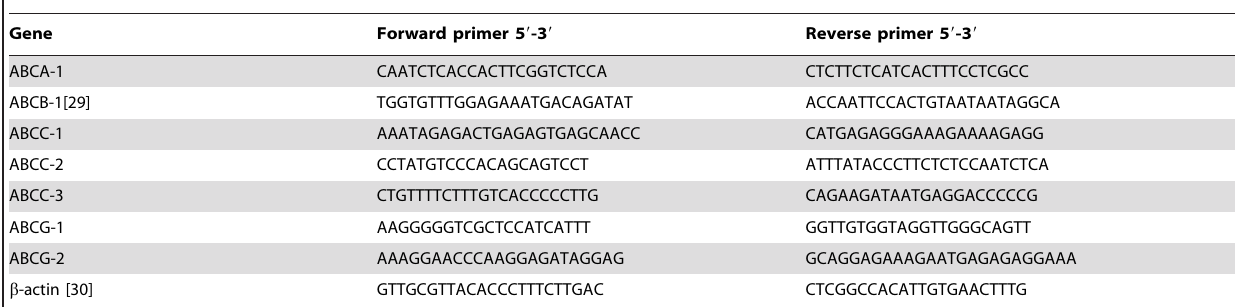
Table 1. Primers used for real-time PCR.